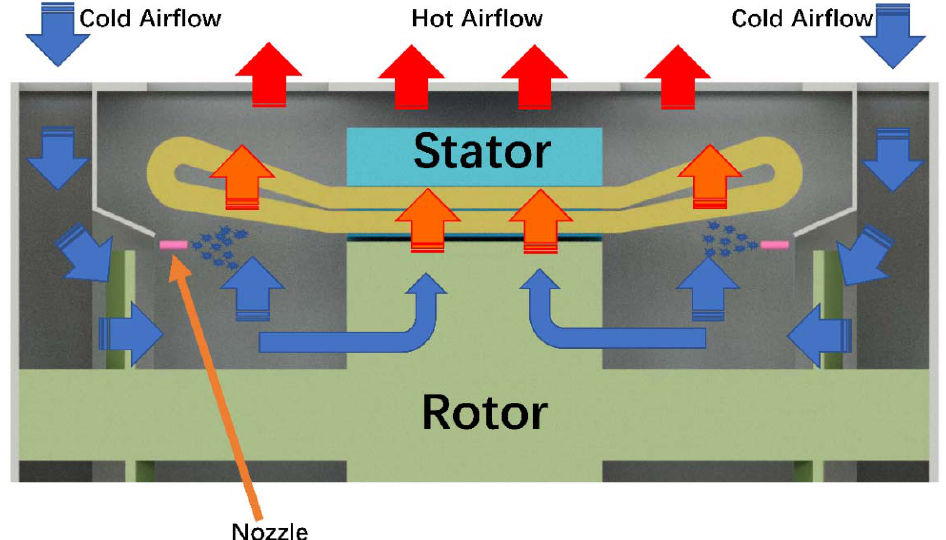
Figure 1. The schematic of the combined circulation system of spray evaporative cooling and air cooling (CCSSECAC).